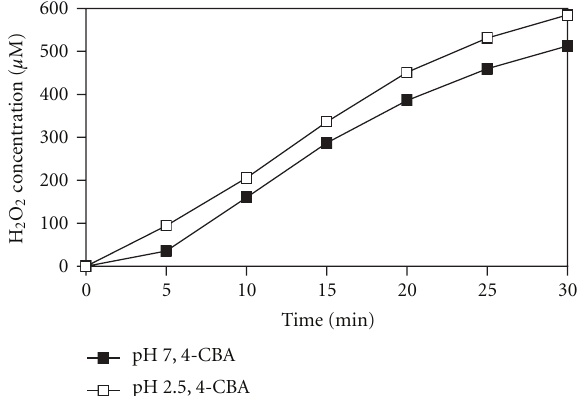
Figure 9: Changes in H 2 O 2 concentrations during O 3 /UV with 4- CBA.